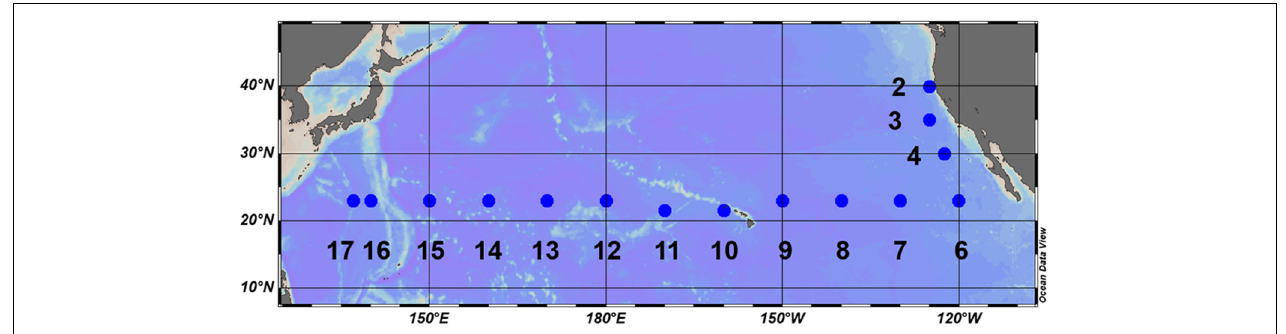
FIGURE 1 | Location of stations during the KH-17-4 cruise (August–October